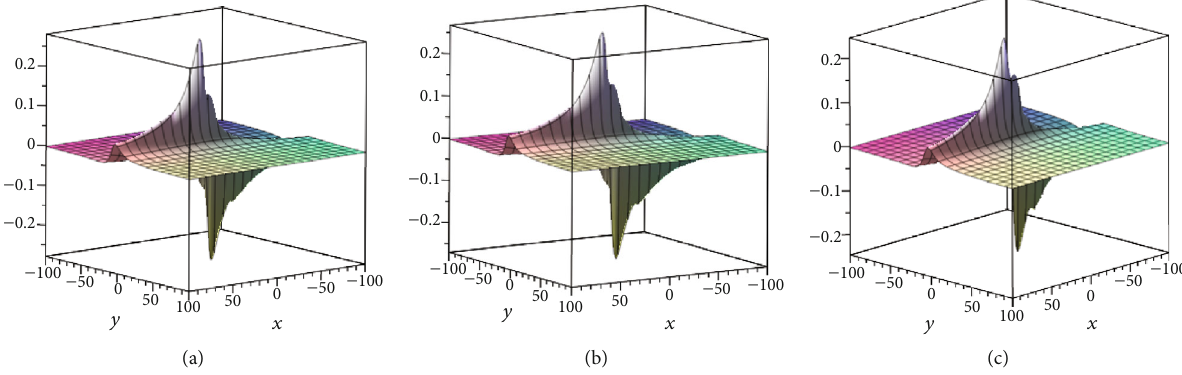
Figure 1: (Color online) soliton solution u with t = 0, 15, 30 : 3D